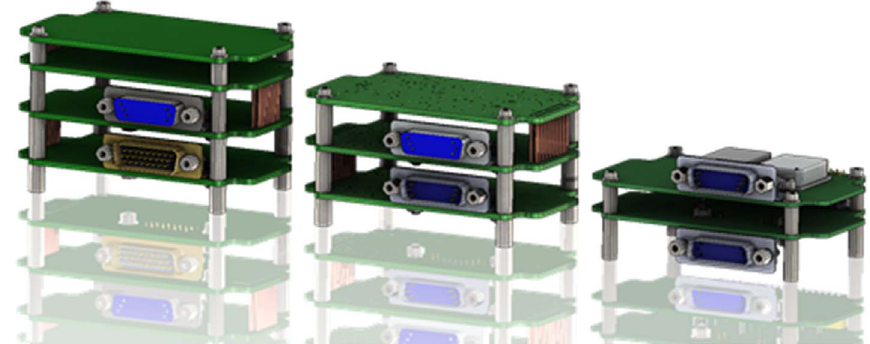
Fig. 11. Illustrating the relative reductions in size for RadMons 1.0, 2.0, and 3.0 (for CIRCE). Figure courtesy SSTL.